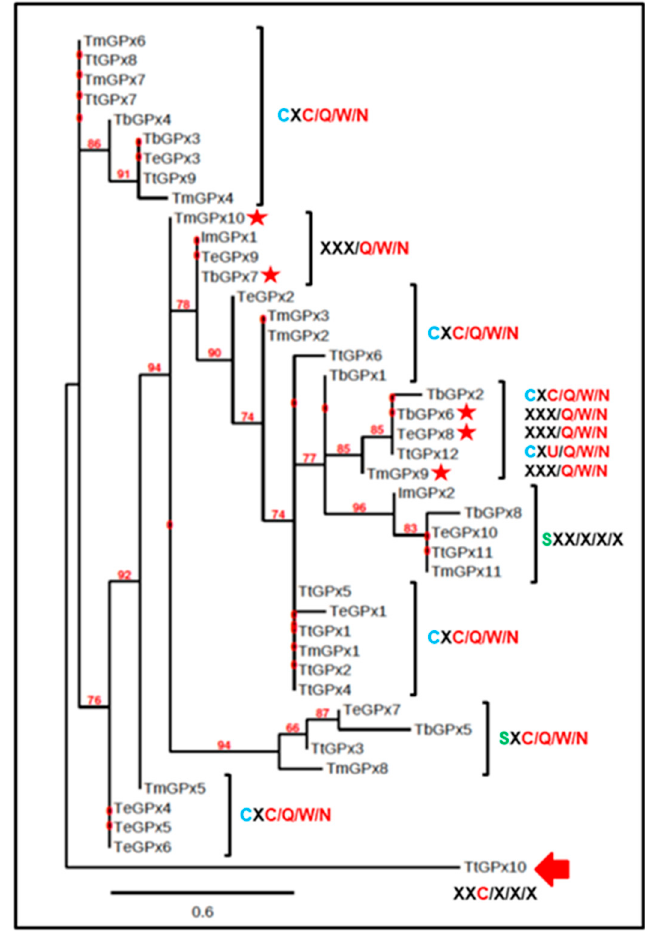
Figure 2. Phylogram of GPx isoforms from all selected Tetrahymena species. Catalytic tetrads are indicated. Species with SECIS elements are indicated by a red star. Numbers indicate bootstrap values from 2000 replicates. Branch lengths are drawn to scale, as indicated by the scale bar. See Table 1 for Tetrahymena species identification.